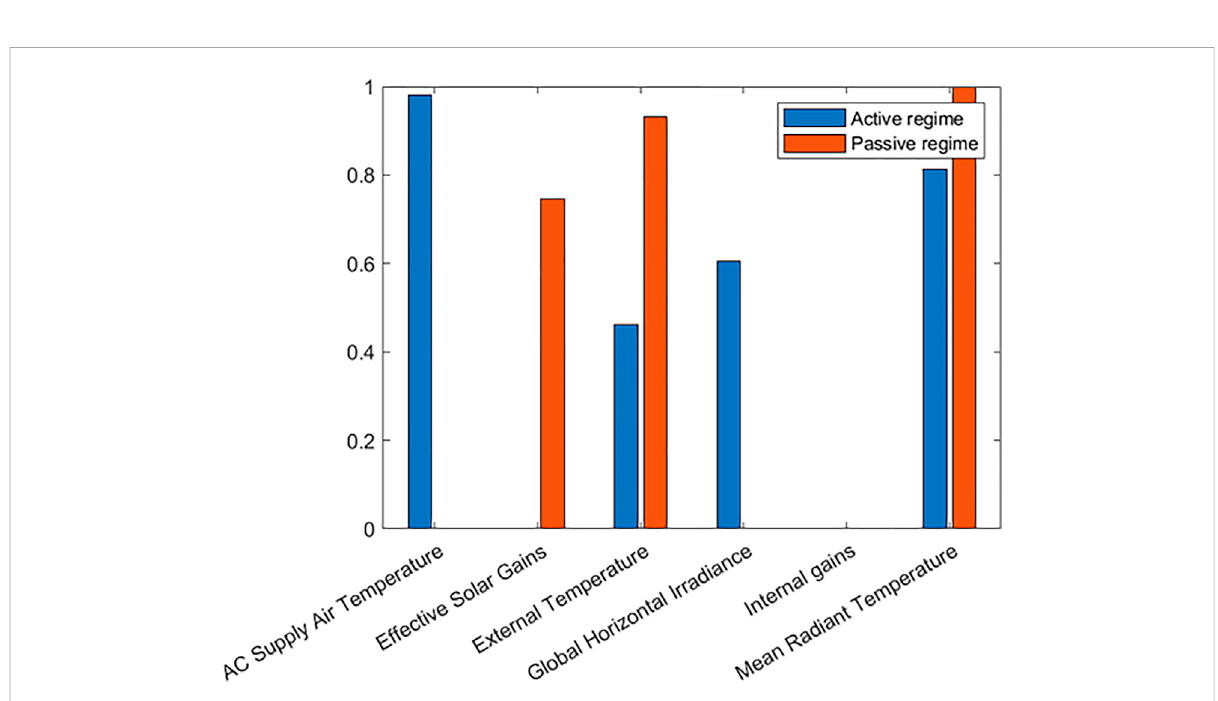
FIGURE 11 Pearson correlation coef fi cient for model inputs and